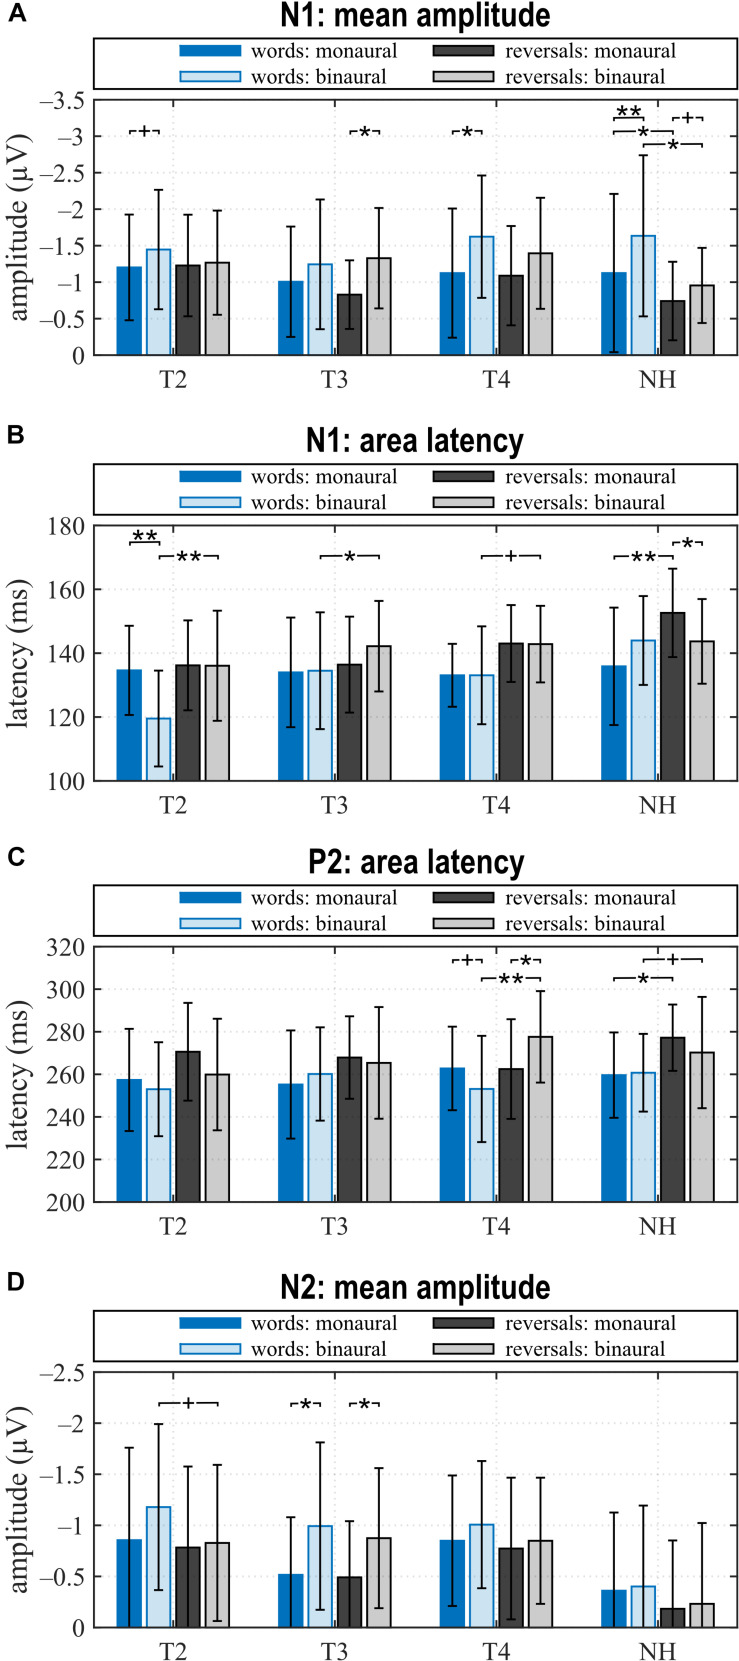
Quantitative AEP results: (A) mean amplitude and (B) area latency of the N1, (C) area latency of P2, and (D) mean amplitude of N2 for the categories “words”, “reversals”, and listening conditions monCI and binaural. (A–D) Means with their standard deviations are shown; significant differences between stimulus categories and listening conditions are indicated (**p < 0.001, *p < 0.05, and trends +p < 0.1).